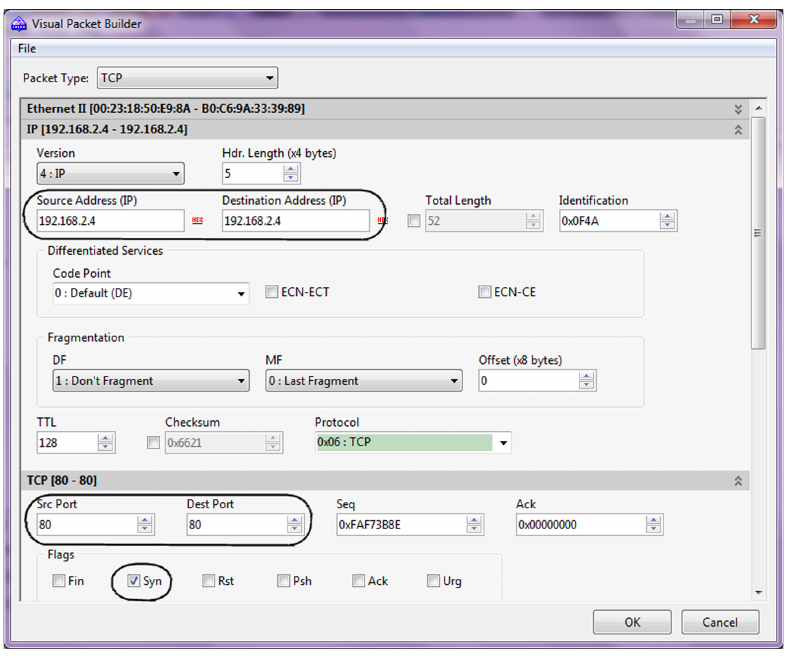
Figure 7. A Land Attack Packet Built Using CommView Visual Packet